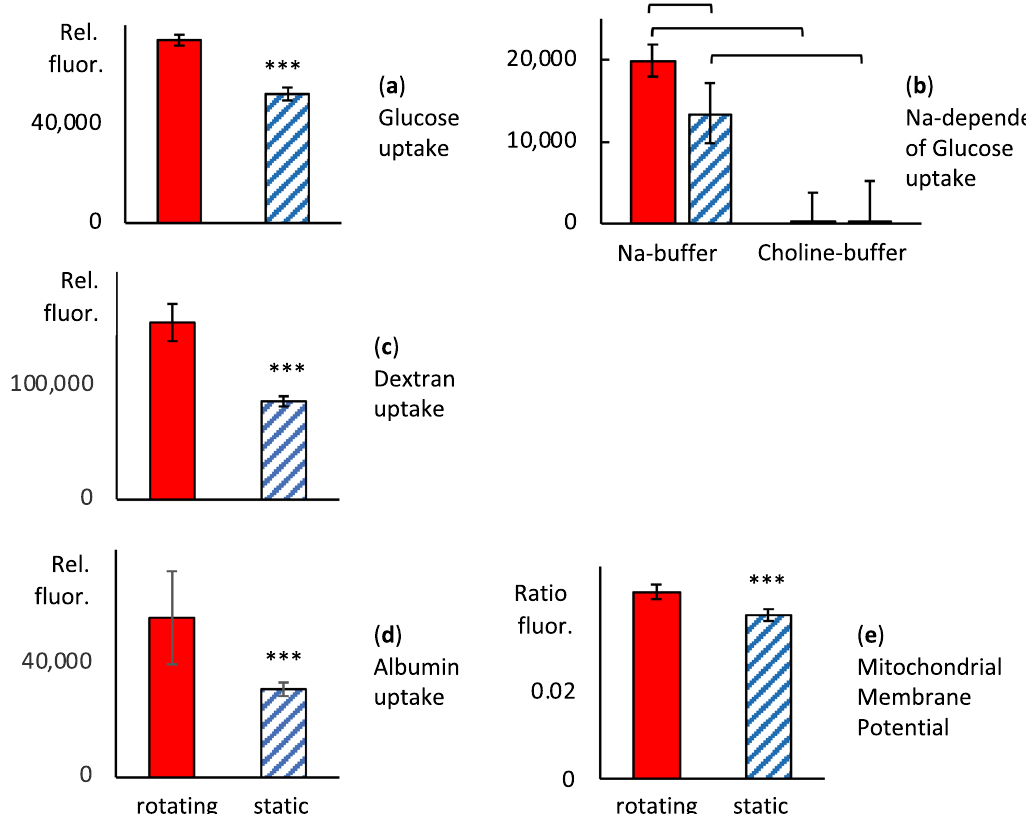
Figure 6. Effect of rotation in cell spinpods on endocytic receptor function, membrane transporter function, and mitochondrial membrane potential. RPTEC/TERT1 cells on Cytodex carrier beads were cultured in cell spinpods under rotating conditions ( ) or static conditions ( ) for 2 days. Panel ( a ) shows the uptake of glucose, measured with the fluorescent substrate 2-NDBG. Panel ( b ) shows the uptake of glucose in Na-containing versus Na-free choline buffer, Panel ( c ) shows the uptake of FITC-dextran. Panel ( c ) shows the uptake of FITC-albumin. Panel ( d ) shows the mitochondrial membrane potential measured with JC10. Cells from all samples were trypsinized off the carrier beads before analysis by flow cytometry. Data is presented as mean fluorescence, in relative fluorescence units, for panels ( a – c ) and as the ratio of red:green fluorescence in panel ( d ). Error bars are ± SEM of six replicates. Asterisks or brackets indicate where differences in the distributions between groups were statistically significant, e.g. p < 0.05, by one-tailed Mann–Whitney U test. Rotation in a cell spinpod induced a statistically significant increase in the uptake of glucose ( p = 0.001, W = 36,